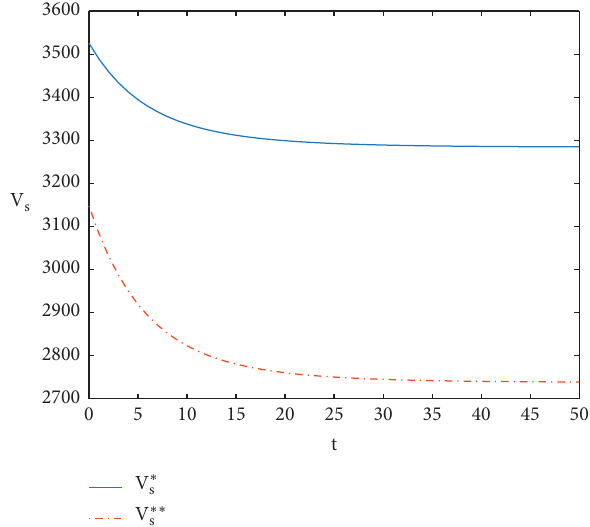
Figure 5: Comparison of environmental pollution losses of Cent- gov.